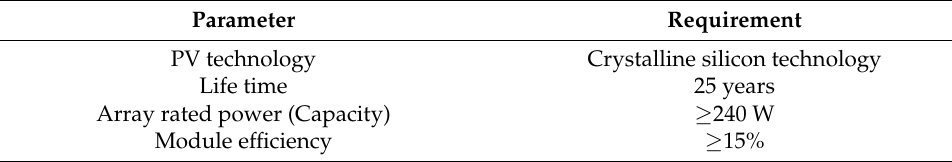
Table 4. PV panels technical specification.